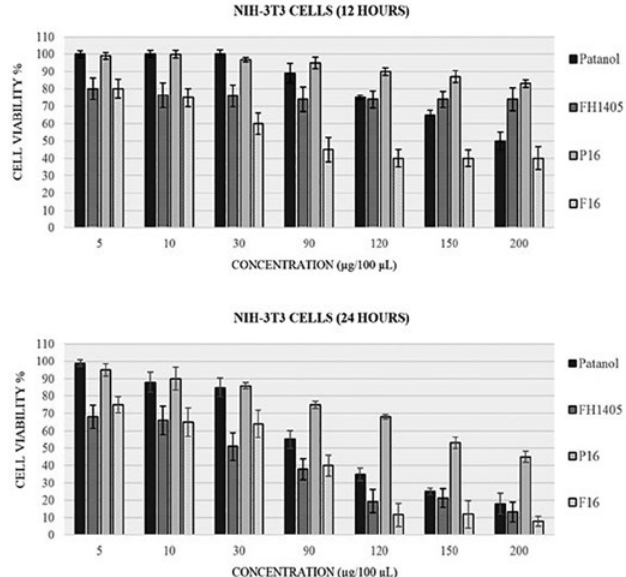
FIGURE 6 - Cell viability of formulations on human 3T3 cells.